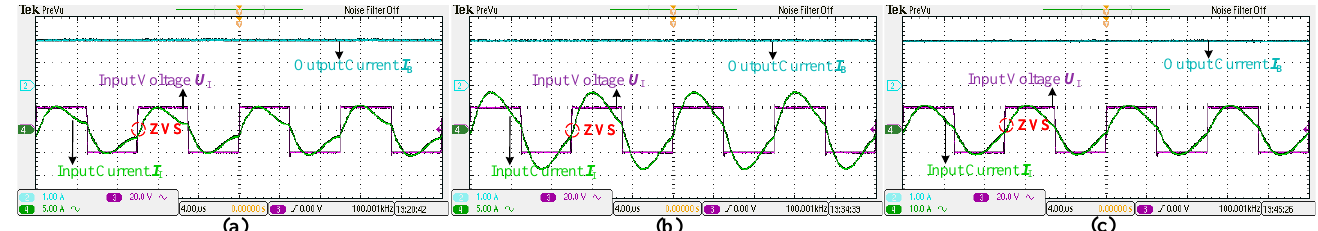
Figure 12. Experimental waveforms of U I , I I and I B under ZVS condition when R B are ( a ) 15 Ω , ( b ) 25 Ω and ( c ) 35 Ω ,